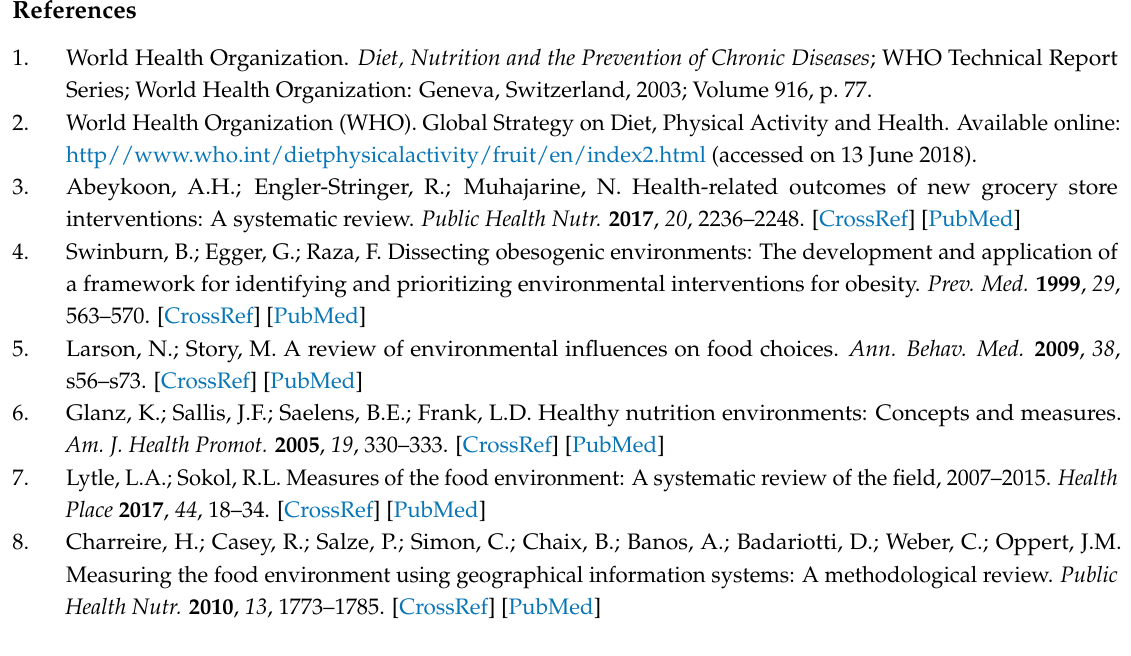
Supplementary Materials: The following are available online at http://www.mdpi.com/1660-4601/15/10/2247/ s1; Table S1. Sensitivity analysis on the odds of infrequent fruit consumption based on different buffer sizes and stratified food environment measures; Table S2. Sensitivity analysis on odds of infrequent vegetable consumption based on different buffer sizes and stratified food environment